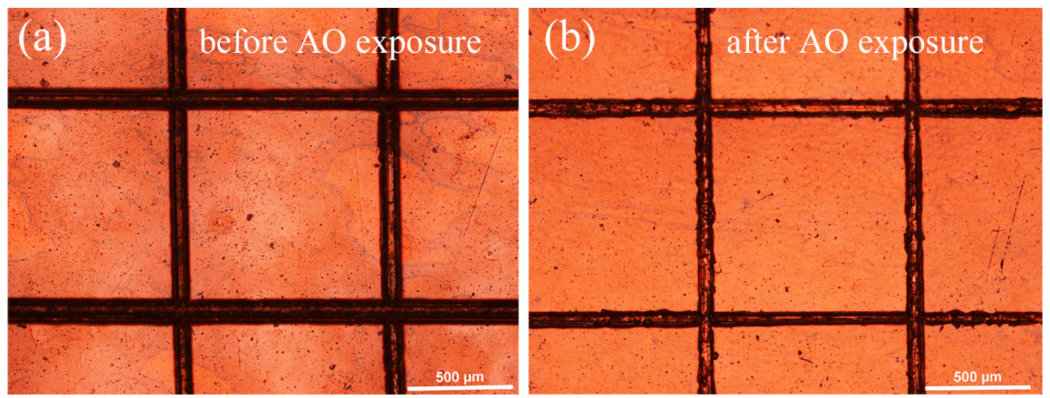
Figure 4. OM images of the coating after the cross-cut test ( a ) before and ( b ) after AO